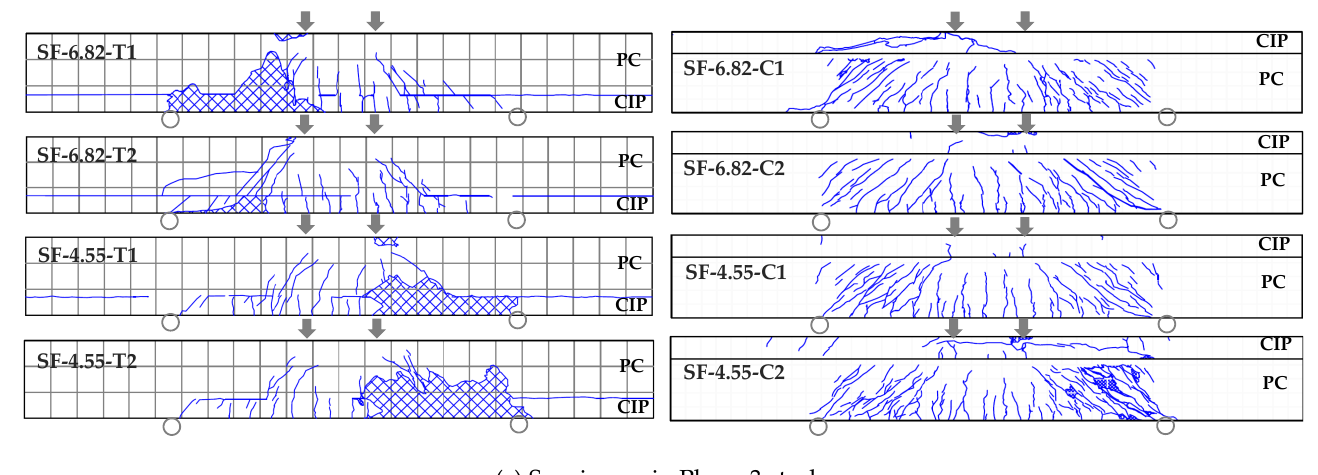
Figure 4. Crack patterns and failure modes.